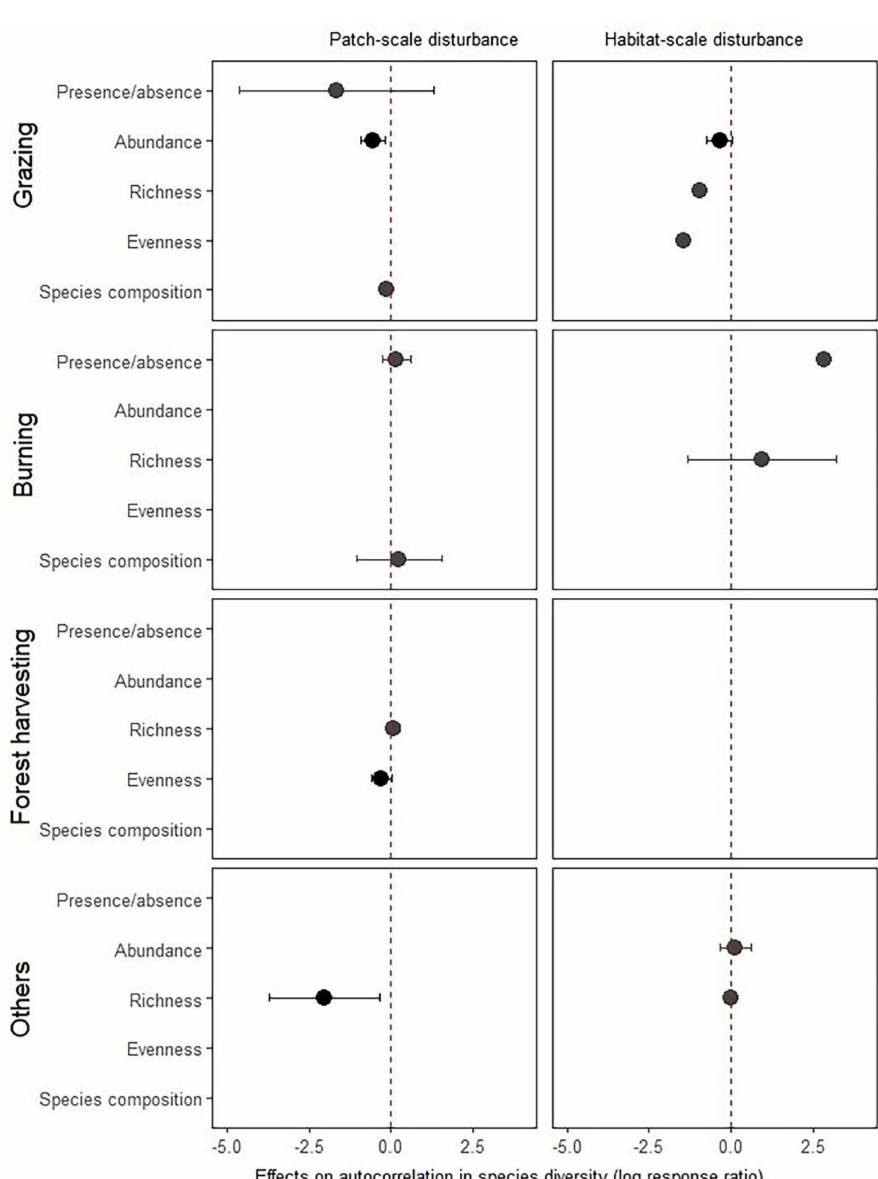
Figure A1. Disturbance effects on overall spatial autocorrelation in different indices of species diversity for different types and scales of disturbance. Shown in the figure is mean (solid point) and 95% confidence intervals (solid line) associated with the mean. Statistically significant effects are shown in drak colour, and non-significant effects are shown in grey. Absence of confidence intervals indicates a single study/record (i.e., knowledge gaps). Key points to note that grazing disturbances, either habitat- (41%) or patch-scale (28.76%), reduces the spatial autocorrelation in species abundance substantially (confidence envelops did not overlap zero). Spatial autocorrelation in evenness (25.38%) and richness (86%) also decreased substantially in case of forest harvesting (cf. clear-cutting) and other disturbances, respectively. Although statistically non-significant (confidence interval overlaps zero), burning seems to impact the spatial pattern of species diversity in a unique fashion. For instance, although spatial autocorrelation decreases at different magnitudes for grazing, forest harvesting or other disturbances, it shows an increasing trend for